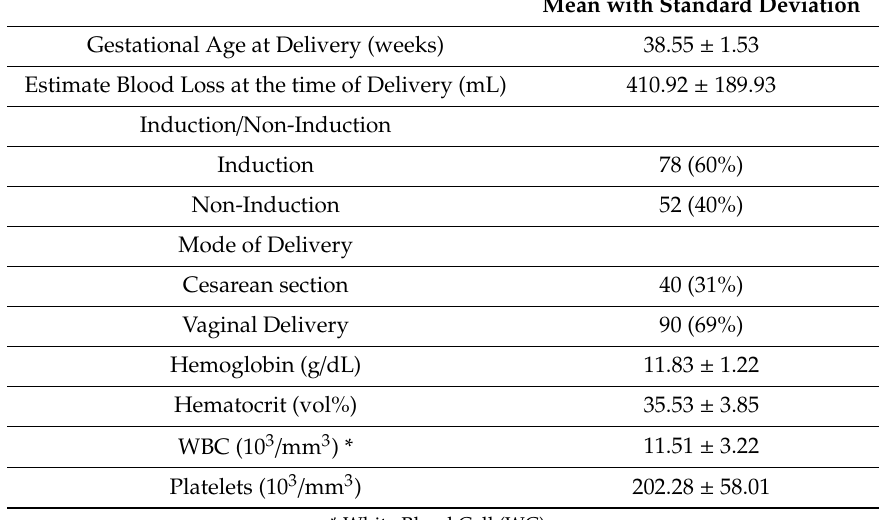
Table 3. Delivery Information. Reported mean ± SD for continuous variables or n (%) for categorical variables. 95% confidence interval.